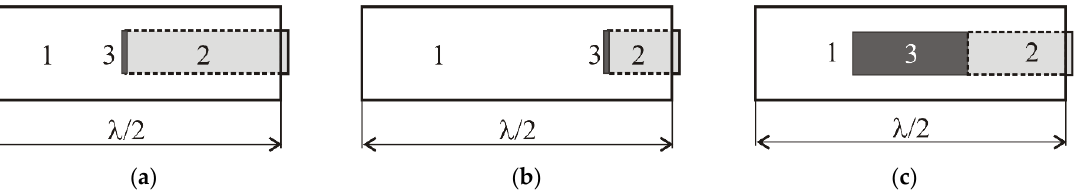
Figure 3. Three types of waveguides for ultrasonic treatment of samples with non ‐ resonant dimen ‐ sions are as follows: for disc samples, clamping them in a stress antinode ( a ); or alternatively, on an intermediate position with non ‐ zero stresses ( b ); for cylindric samples with lengths significantly less than a half ‐ wavelength of ultrasound ( c ). 1—half ‐ wave cylinder; 2—clamping cylinder; 3—sample.